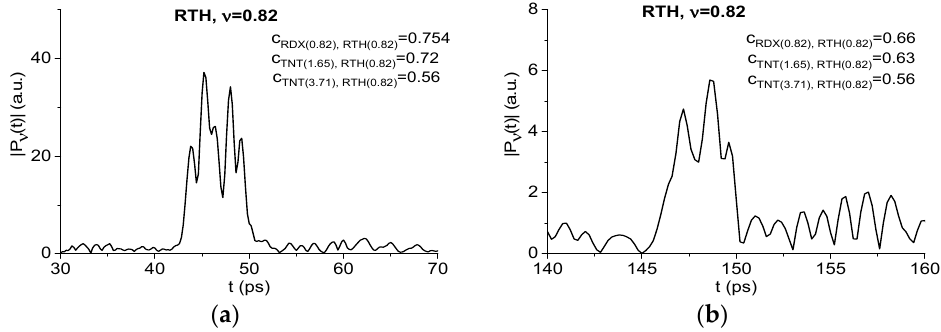
Figure 21. RTH spectral line dynamics computed at the frequency ν = 0.82 THz in the time intervals t = [30, 70] ps ( a ) and [140, 160 ] ps ( b ).